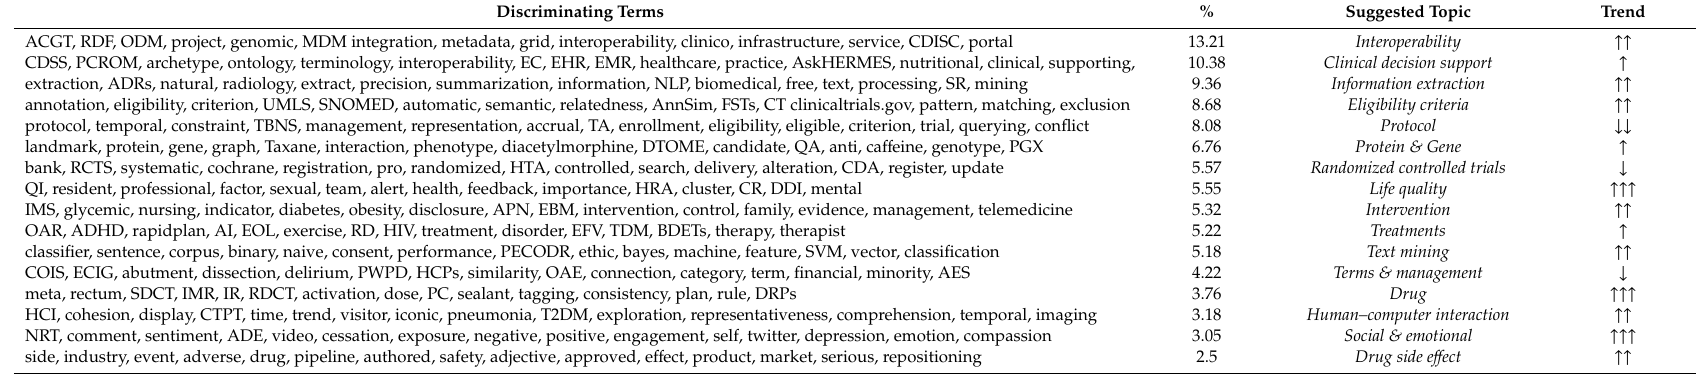
Table 10. The 16 structural topic modeling (STM) results with the discriminating terms, topical proportions, suggested topic labels, and trend test results. Discriminating Terms % Suggested Topic